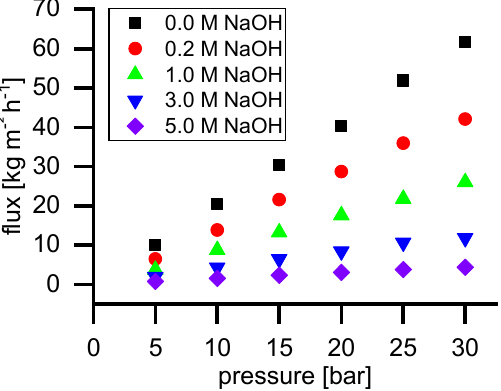
Figure 2. Permeate flux of water and NaOH solutions with different concentrations in the range from 5 to 30 bar at 40 °C.